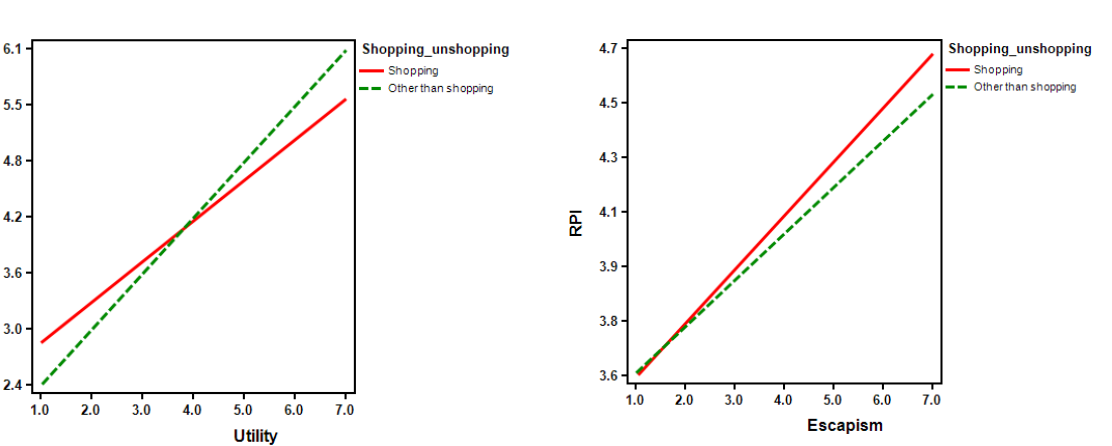
Figure 4. Layout-utility interaction Figure 5. Layout-ambiance interaction